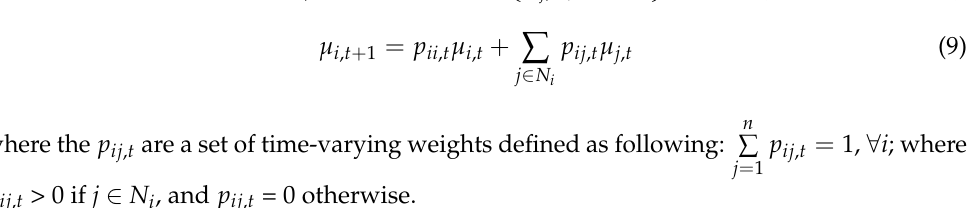
Figure 3. Comparison between the consumed and generated power as well as the minimum and the maximum power.